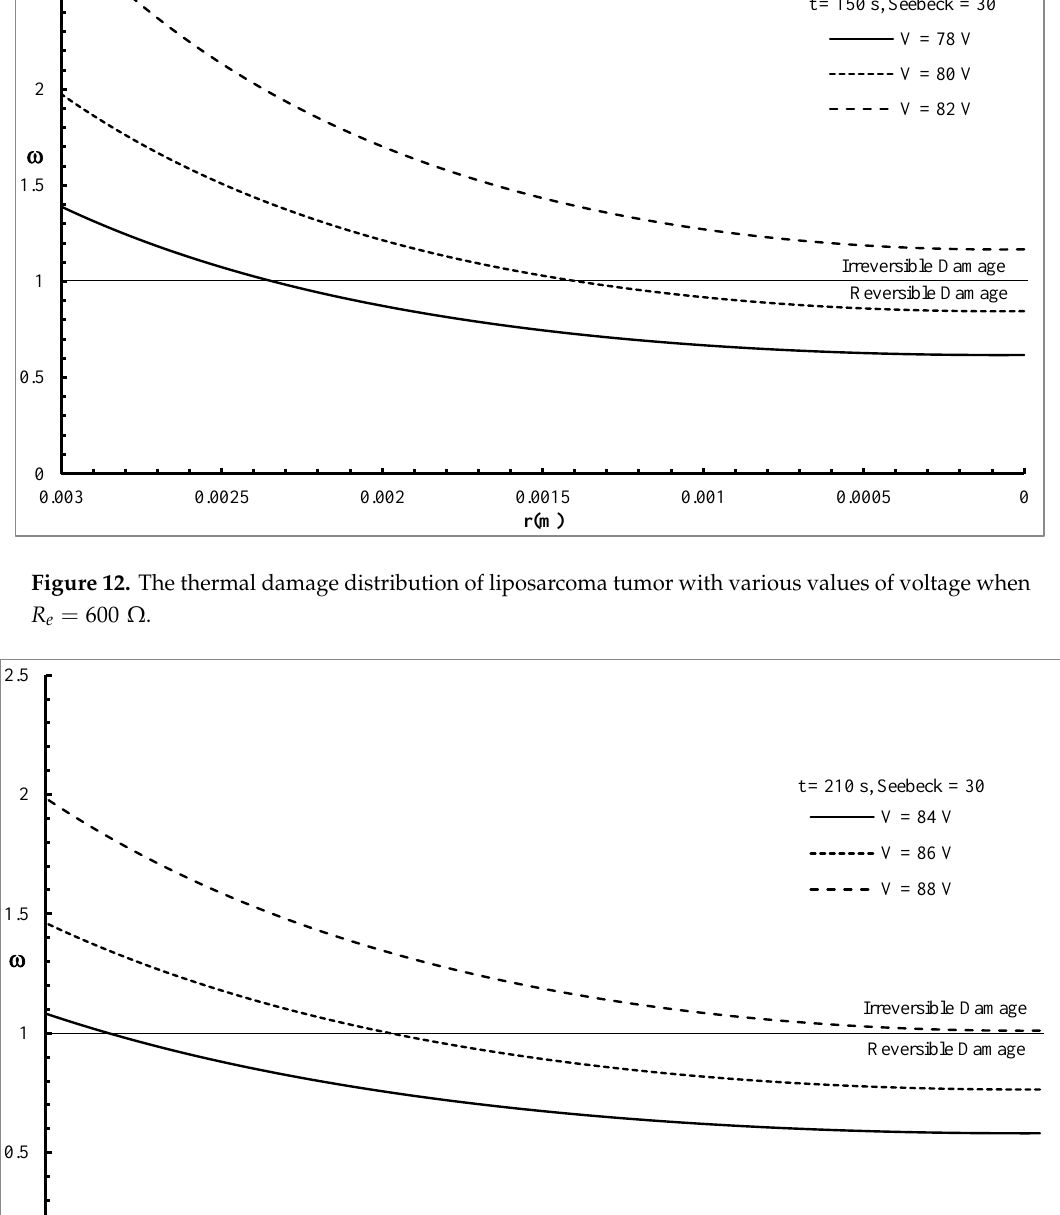
Figure 13 . The thermal damage distribution of lipoma tumor with various values of voltage when Figure 13. The thermal damage distribution of lipoma tumor with various values of voltage when 1300 R   . R e = 1300 Ω e